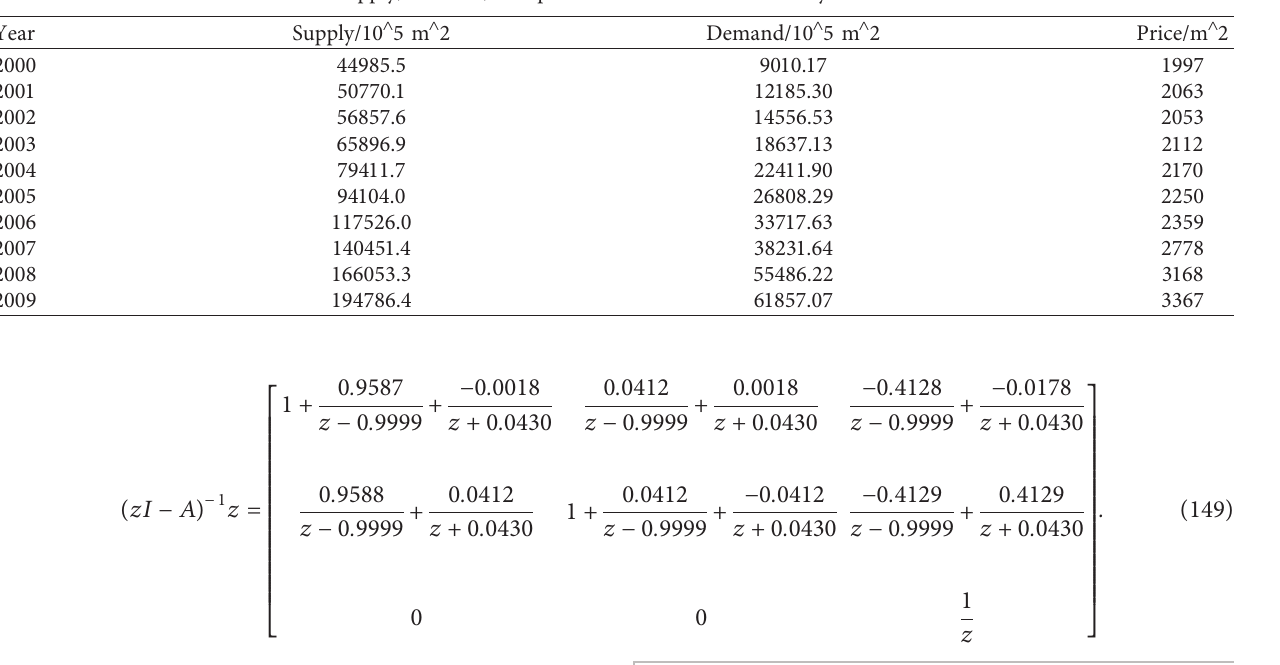
Table 1: The supply, demand, and price of real estate in a country from 2000 to